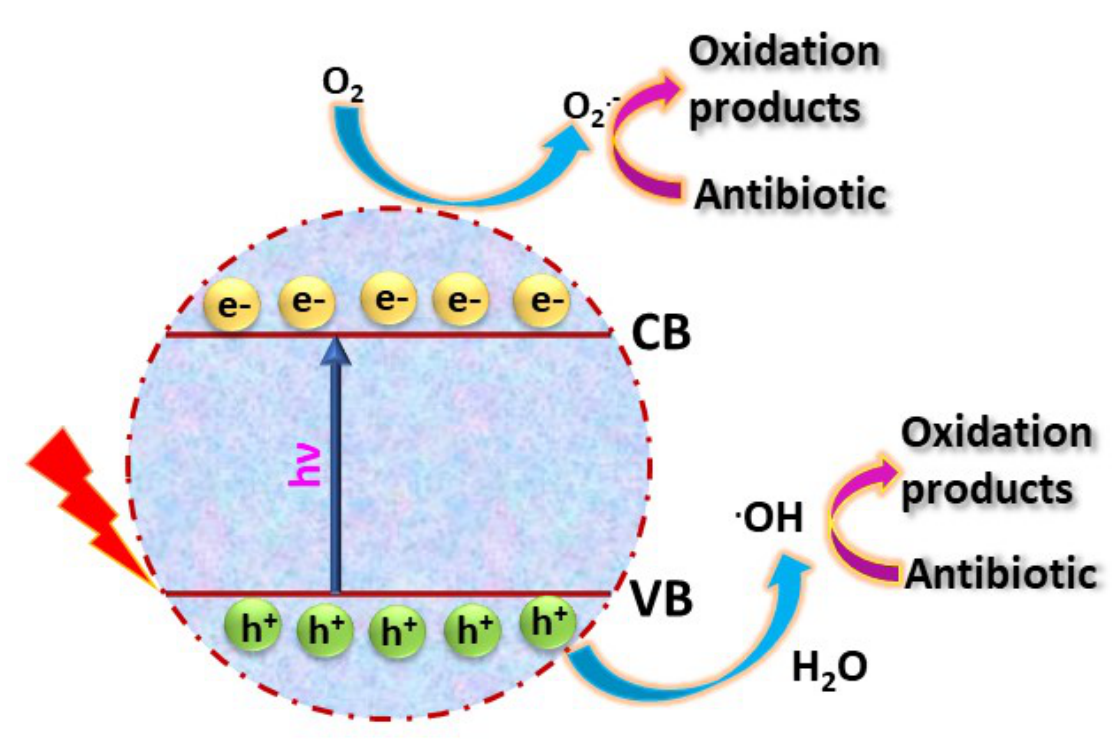
Figure 6. ( a – c ) Photocatalytic degradation of NFZ with various quenchers: AO, BQ, and TBA. ( d ) A comparison of the NFZ degradation in the presence of different scavengers. ( e ) Degradation curves in the presence of different scavengers. ( f ) Simulation of pseudo-first-order kinetics of NFZ using 1 in the presence of quenchers.